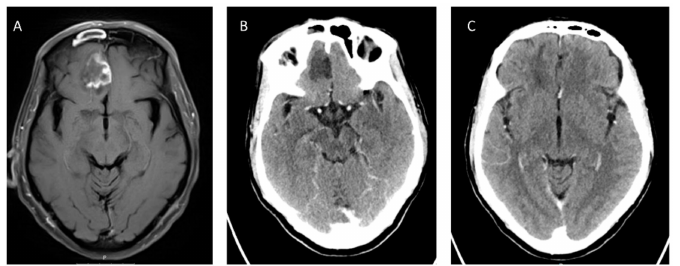
Figure 1. Cerebral mucormycosis. A 67-year old male with acute B-cell lymphoblastic leukemia, chemotherapy-induced neutropenia and high-dose corticosteroid treatment, developed sinopulmonary mucormycosis with cerebral extension involving the right frontal lobe (T1 weighted magnetic resonance (MR) image ( A ) and computed tomography (CT) ( B )). Culture from sinus biopsy and stereotactic brain biopsy grew Rhizopus arrhizus . The patient was treated with Liposomal Amphotericin B (10 mg / kg per day) and Isavuconazole, without debridement of brain tissue. Follow-up CT after 4 months of treatment shows near-complete resolution ( C ). Courtesy: M. Weinberger and N. Carmi